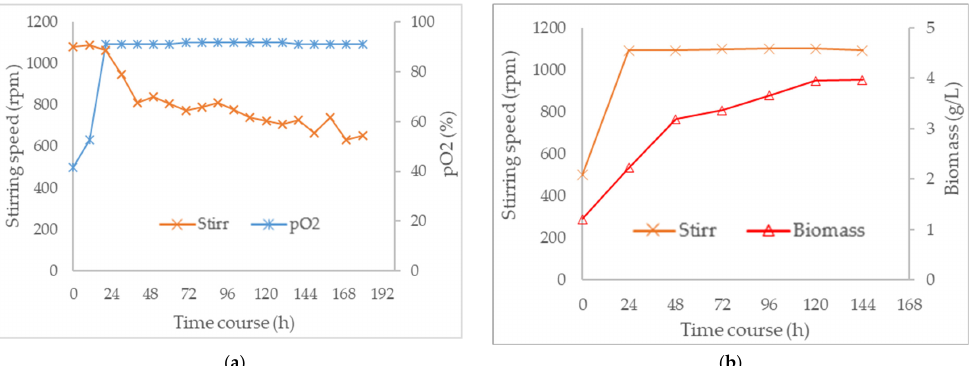
Figure 6. ( a ) Maintenance of dissolved oxygen at 90% over time (0 to 168 h) in a submerged culture of T. albobiverticillius 30548 in a 2 L bioreactor showing the variation of stirring speed over time (0 to 160 h); ( b ) effect of agitation speed over time (0 to 160 h) on biomass production in a submerged culture of T. albobiverticillius 30548 in a 2 L bioreactor in combination with dissolved oxygen at 90%.